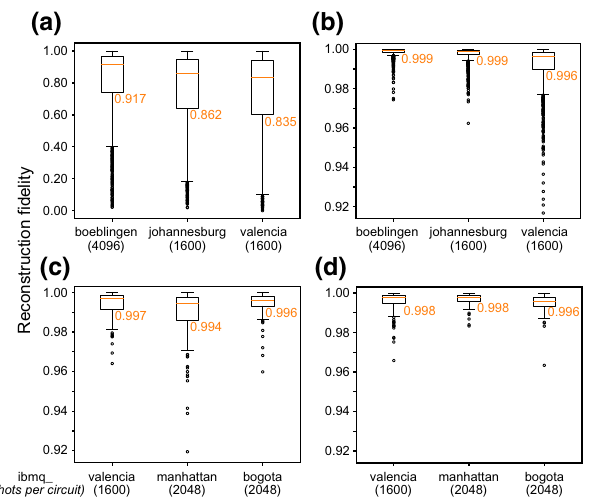
FIG. 5. The reconstruction fidelity of various three-step process-tensor procedures when using a minimal complete basis. Each data point represents a different randomly generated unitary sequence. The top and bottom of the box plots are 75 and 25 per- centiles, the orange line is the median (figure also printed), the whiskers are 1.5 times the interquartile range, and any remaining data points are outliers beyond this. We compare reconstruc- tions with (a) a randomly generated basis and linear inversion, (b) a randomly generated basis processed by maximum likeli- hood, (c) a mutually unbiased unitary basis (MUUB) processed with linear inversion, and (d) a MUUB processed with maximum likelihood. The results showcase high-fidelity physical process tensors with minimal resources, in contrast to Ref. [21] where the random-basis data are